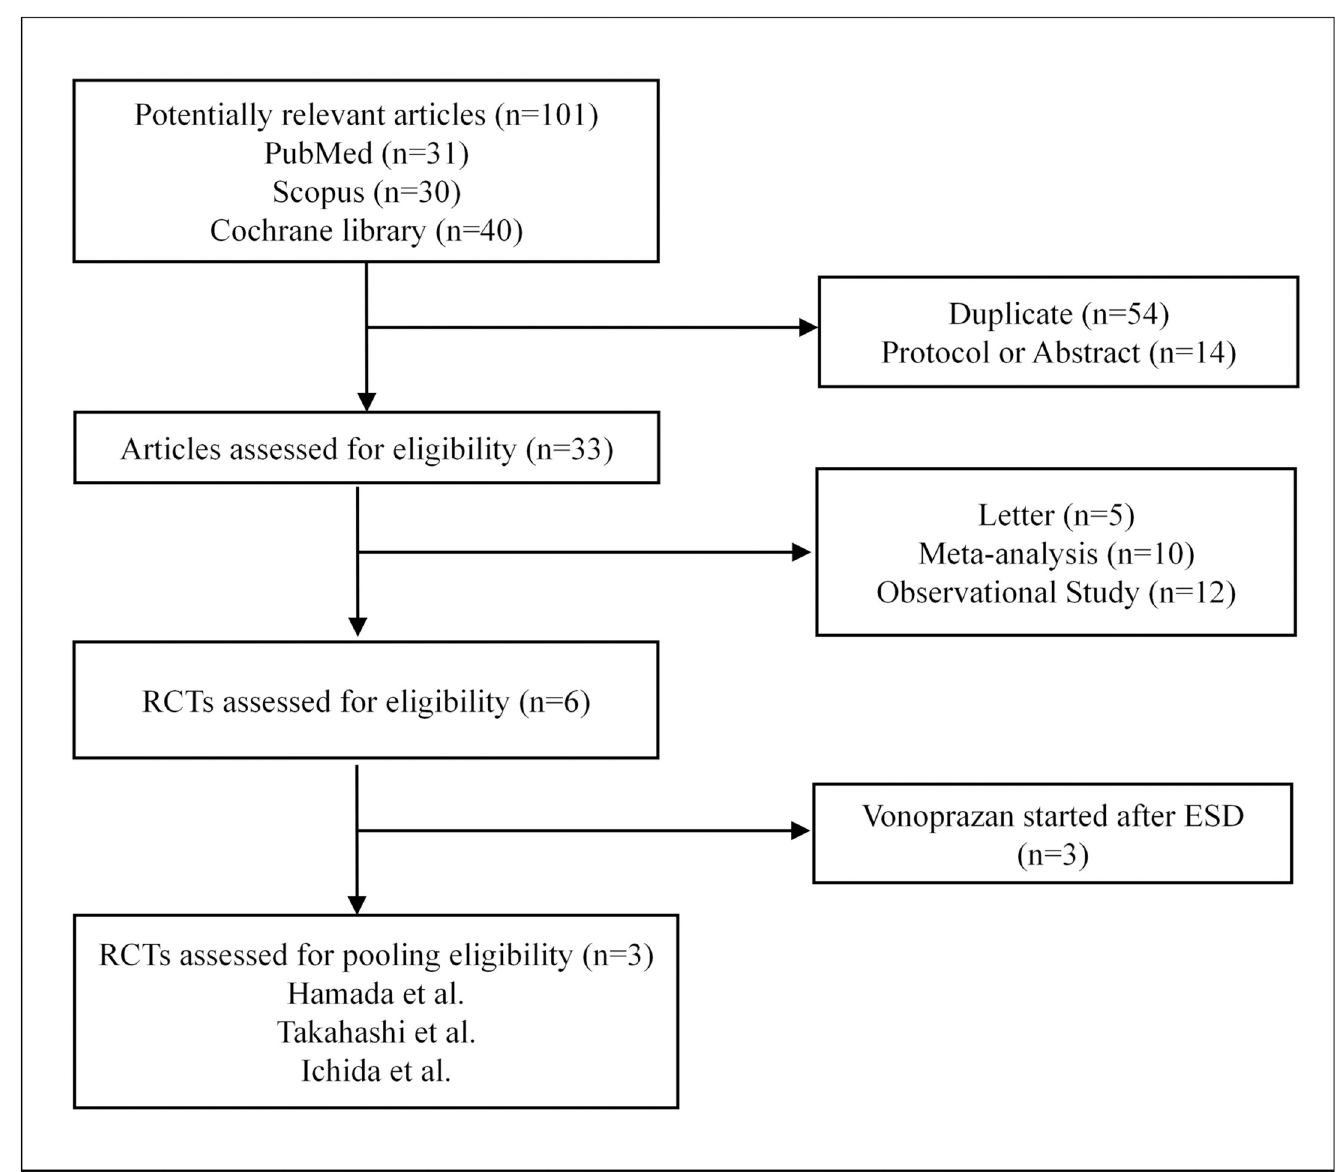
Fig 1. Flow diagram of assessment of randomized controlled trials used in CDS. RCTs, Randomised controlled trials; ESD, Endoscopic submucosal dissection.